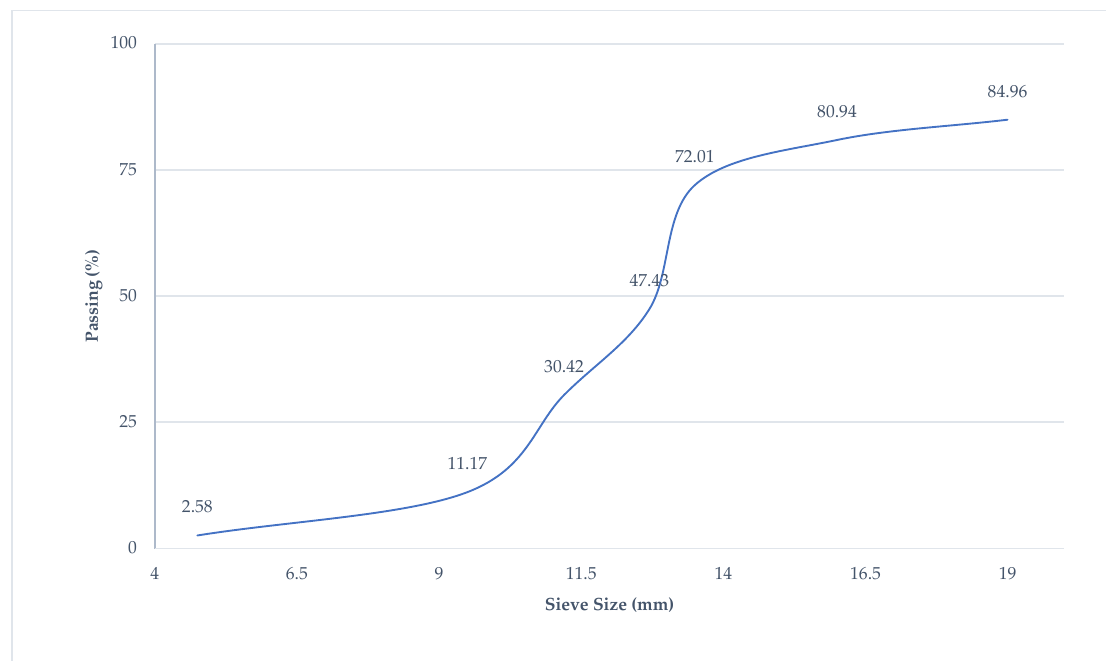
Figure 3. Granulometric Curves of Fine Aggregates.